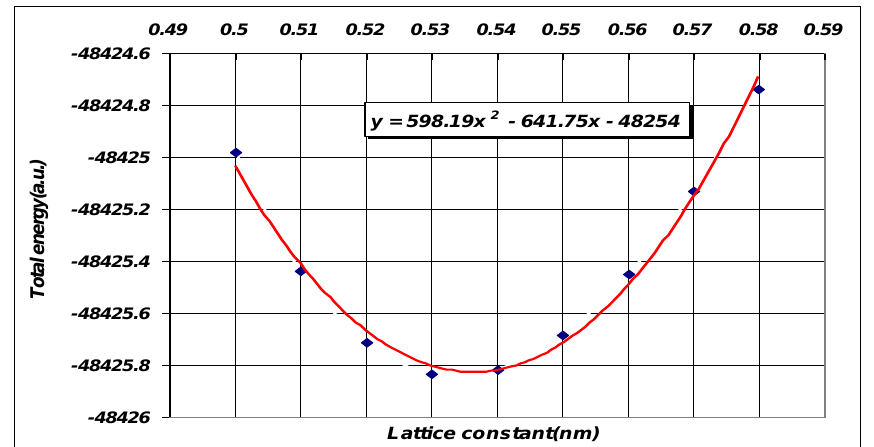
Fig. 2: Total energy of 64 atoms of Al As